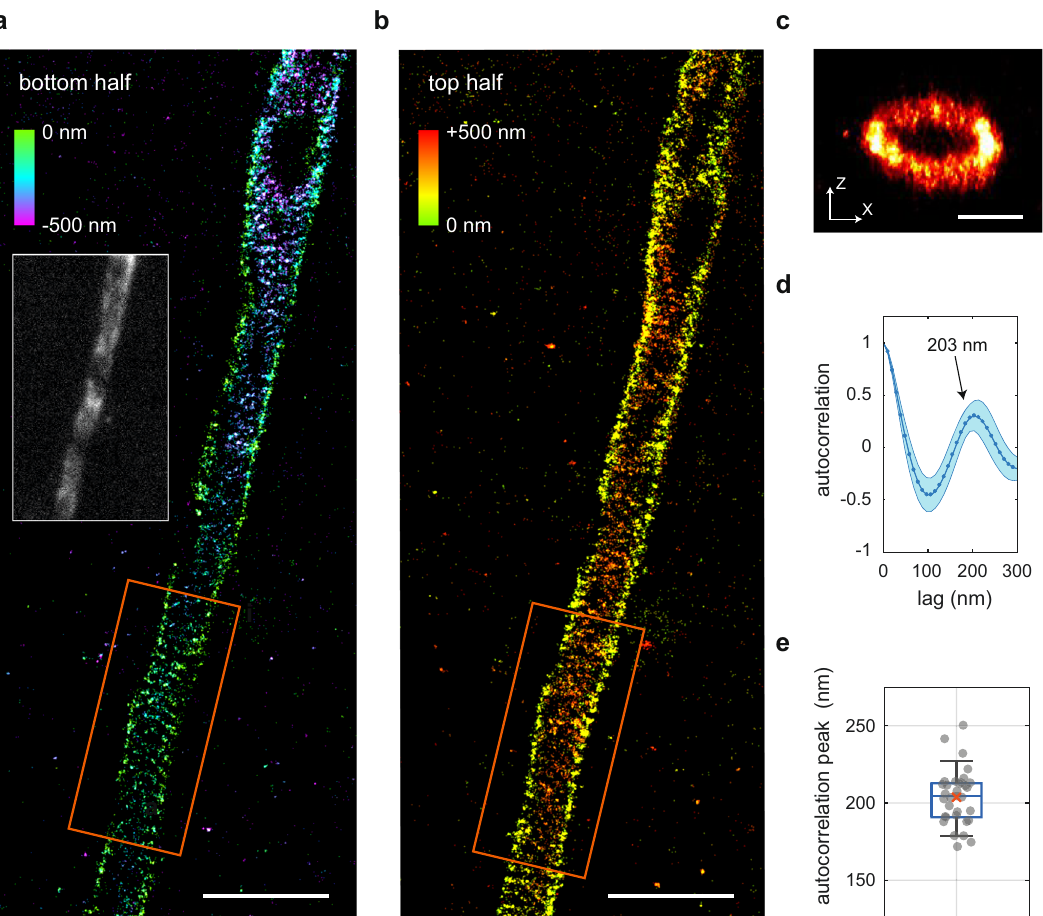
Fig. 3 Resolving the nanoscale spectrin organization in axons at 50 μ m depth. a , b SMLM reconstruction of the upper half ( a ) and lower half ( b ) of a layer 5 pyramidal neuron AIS stained for βΙ V-spectrin in a rat brain slice at 50 μ m depth. Color encoding indicates the z-position. Scale bars indicates 2 μ m. Insert with white rim shows the wide fi eld image prior to aberration correction. The holes in βΙ V-spectrin pattern are likely sites of synaptic connections. Scale bar indicates 2 μ m. c z-x cross-section of the rectangular orange area indicated in a , b . Scale bar indicates 500 nm (both directions). d The average autocorrelation (blue line) of 30 line segments in the reconstruction of a , b and Supplementary Fig. 11 shows a peak at 203 ± 10 nm. Shaded region indicates the standard deviation. e Distribution of the estimated autocorrelation peaks of the individual line segments of reconstructions of a , b and Supplementary Fig. 11. Boxplot indicates 9/91-precentile, 25/75-precentile, and median. Red cross indicates the mean autocorrelation distance. See also Supplementary Fig. 11. Repeated n = 12 times in four distinct samples with similar results. Source data are available as a source data fi